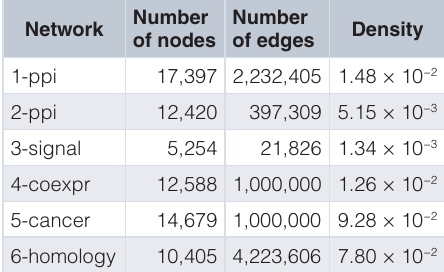
Table 1. Number of vertices, of (non-zero- weighted) edges and density of the biological networks used in the DMI